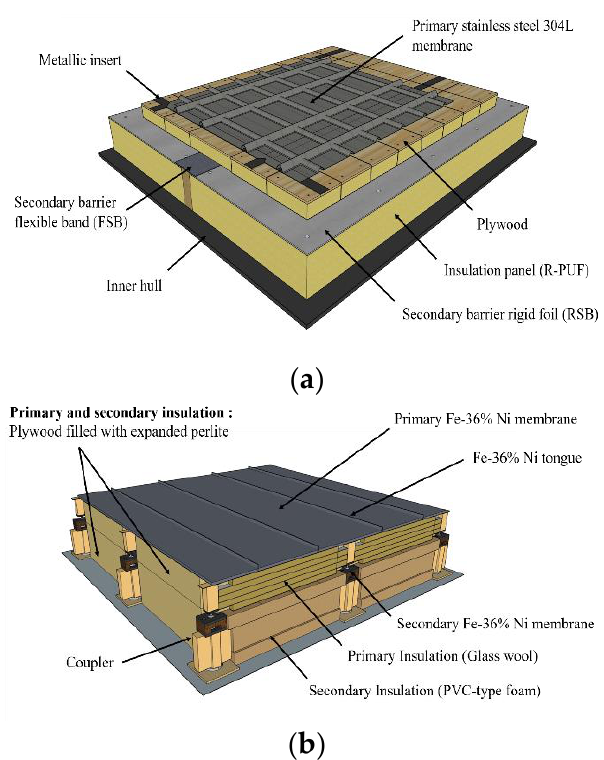
Figure 1. ( a ) Mark III and ( b ) NO96 liquefied natural gas (LNG) cargo containment system (CCS).